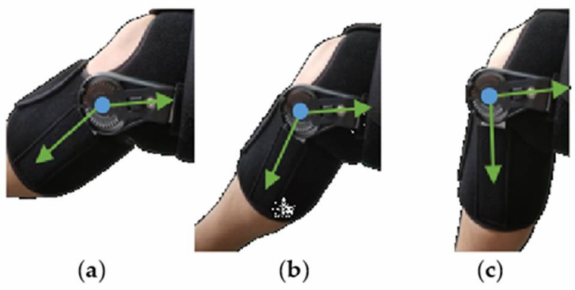
Figure 7. The three simulated disability levels of the testers. ( a ) Simulated disability level 1. ( b ) Simu- lated disability level 2. ( c ) Simulated disability level